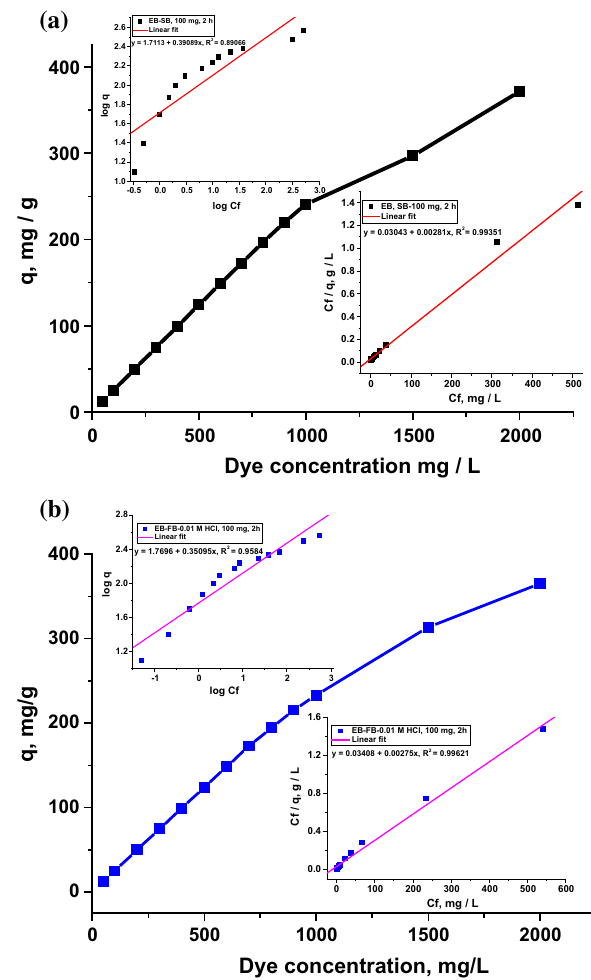
Fig. 10 a Adsorption isotherms of EB onto SB. b Adsorption iso- therms of EB onto FB-0.01 M